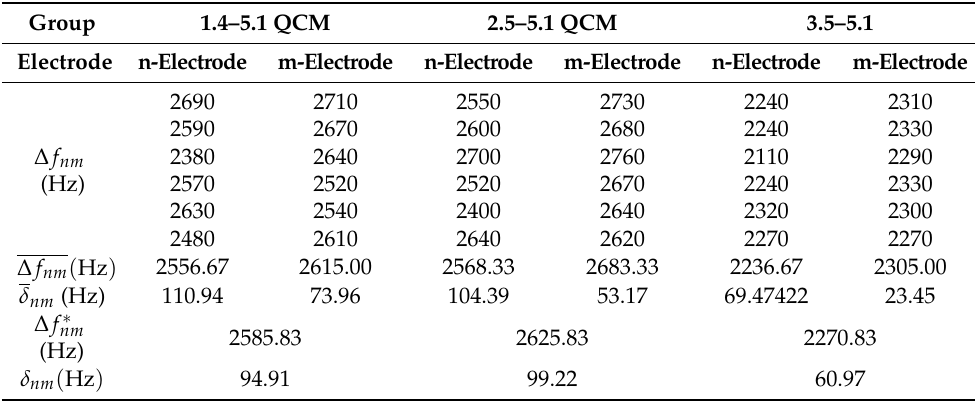
Table 1. The experimental result for the effect of electrode diameter on the QCM mass sensitivity of n-m electrodes [33]. ∆ f nm is the frequency change before and after the second plating. ∆ f nm and δ nm are the average value and the standard deviation of the frequency shift in each subgroup, respectively. ∆ f ∗ nm and δ nm are the average value and standard deviation of the frequency shift in each group, respectively.